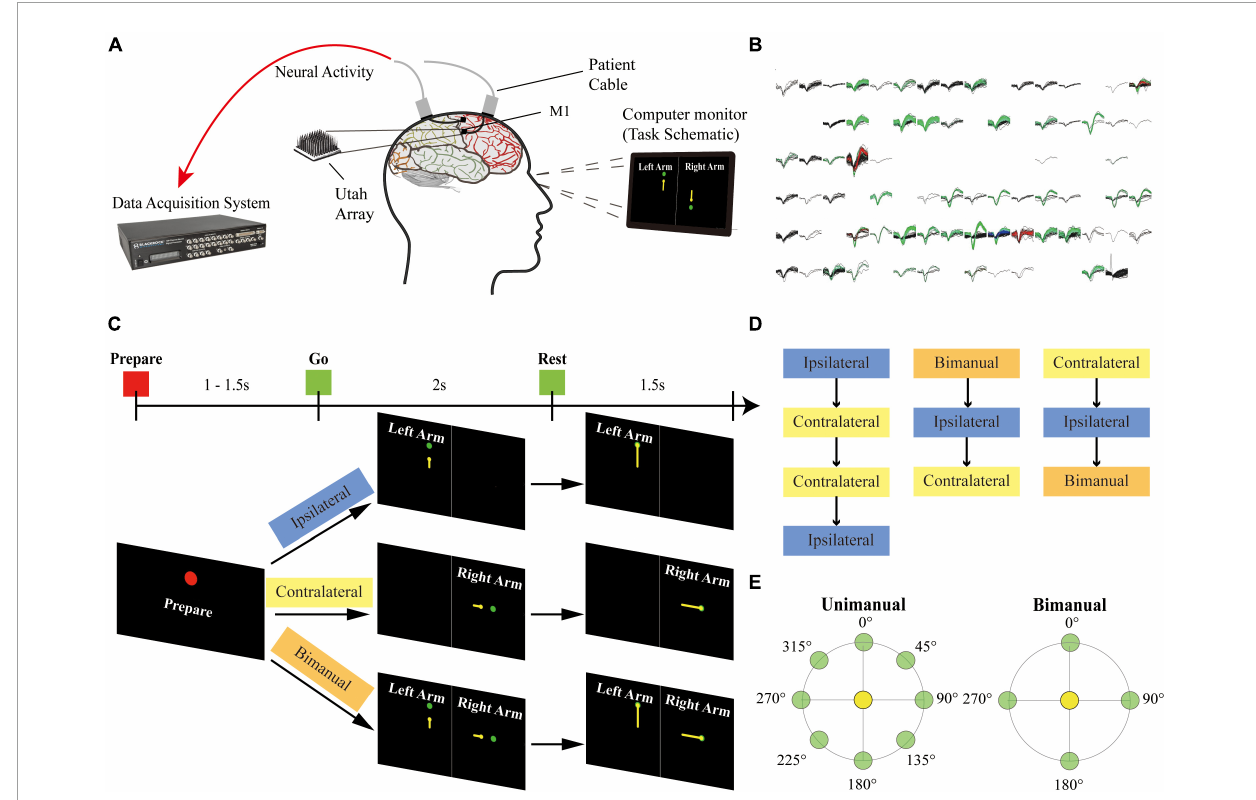
FIGURE1 Setup of the experiment. (A) The participant was implanted with two 96-channel microelectrode arrays in his left M1 area. The neural signal was recorded with the NeuroPort system from the arrays during the motor imagery task. (B) Example panel of the spike activities for 96-channel arrays during a recording session. Each sub-panel displayed the spikes for a channel, and each color except for black indicated a sorted neuron. (C) Task schematic. The participant performed motor imagery for the center-out reaching task with the ipsilateral arm, the contralateral arm, and the bimanual arms in different blocks. Each trial contains a Prepare phase, a Go phase for imagery of arm movements from the center target (yellow circles) to the peripheral targets (green circles), and a Rest phase. Text and colored shapes were displayed as the movement cues. (D) Blocks of different movement types recorded on each day were presented in a pseudorandom order. (E) Overview of 8 peripheral targets on a circle for the unimanual trials and 4 peripheral targets for each arm for the bimanual